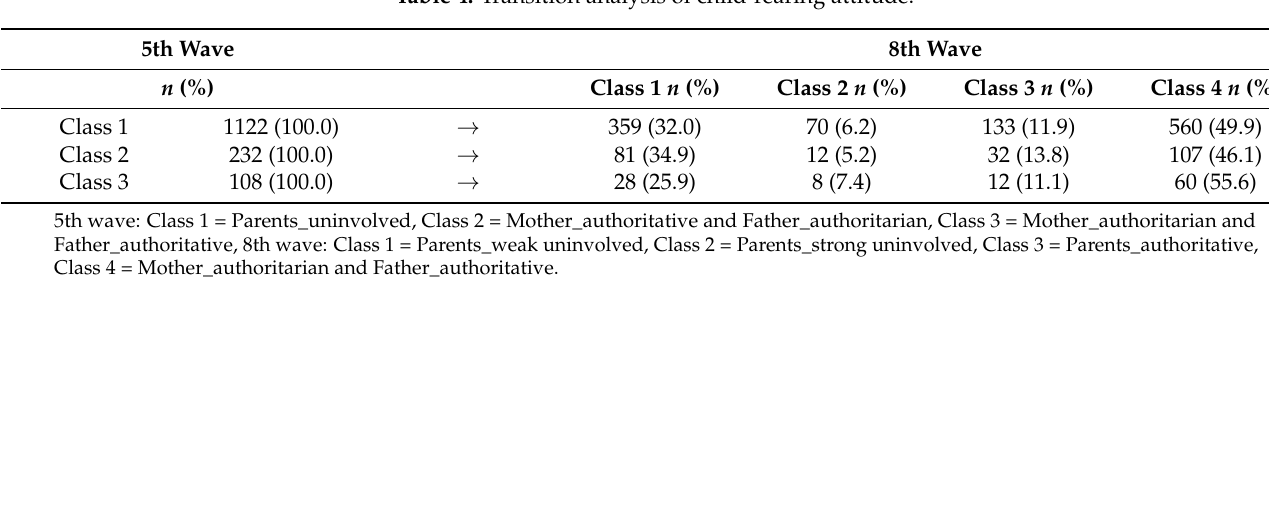
Figure 2. Latent class of child-rearing attitude (8th wave).